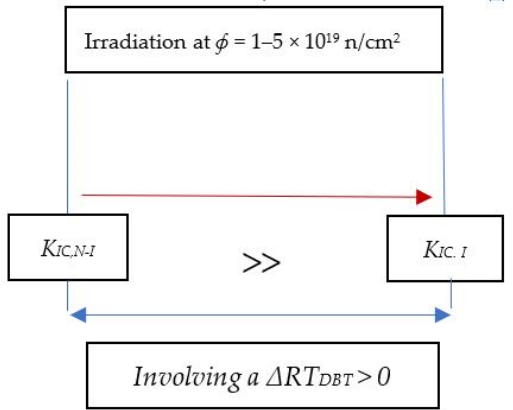
Figure 2. Irradiation effect on K IC and ∆ RT DBT .